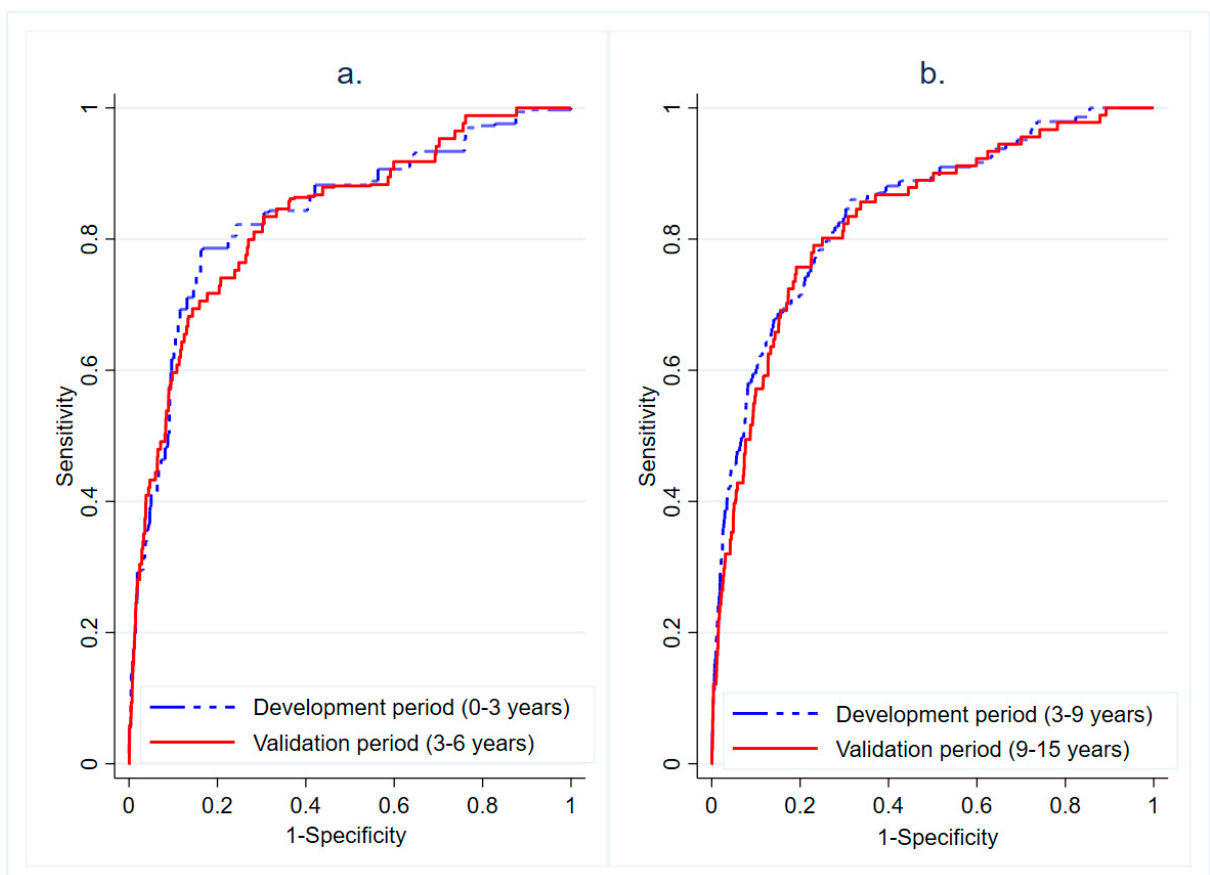
Figure 2. ( a ) Receiver operating characteristic (ROC) curves for the development period of 0–3 year and validation period of 3–6 years and the ( b ) development period of 3–9 years and validation period of 9–15 years. Table 2. Expected and observed probability and number of PCa deaths in the development and validation periods for quintiles of prognostic index.